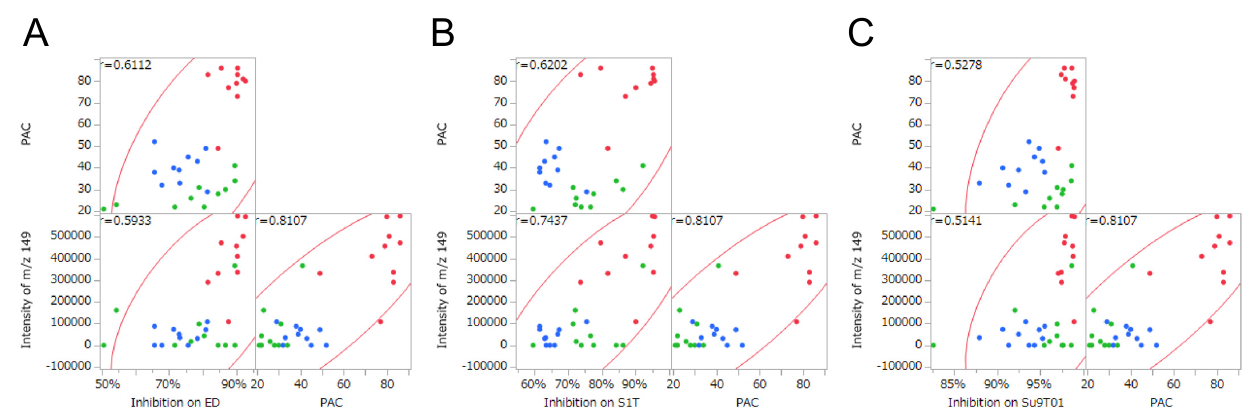
Figure 5. Scatterplot matrices among inhibitory effect against ATL cells, peak intensity at m/z 149 on DI-EI-MS analysis, and the PAC content. ( A ) ED cells, ( B ) S1T cells, and ( C ) Su9T01 cells. Green circles indicate leaves, red circles indicate stems, and blue circles indicate leaf/stem mixtures.